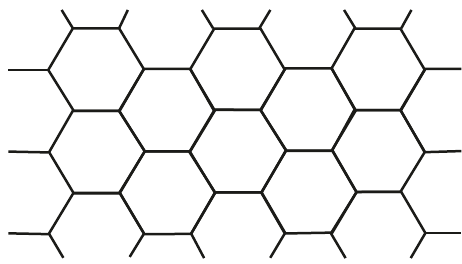
Figure 3: The division of hexagonal